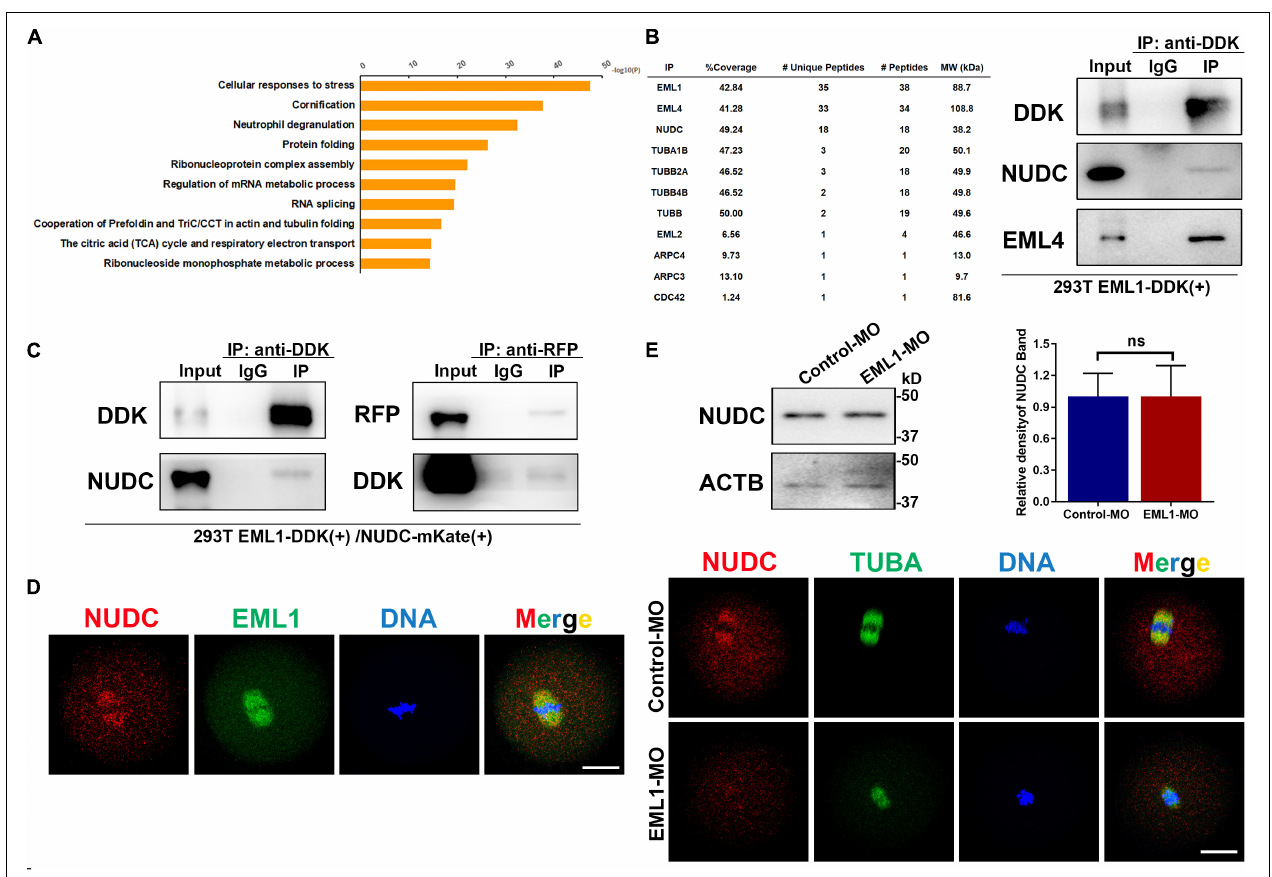
FIGURE 10 | Potential interacting partners identified for EML1. (A) Gene enrichment analysis of the interacting proteins of EML1 identified by IP-MS. (B) List of IP-MS identified EML1interacting proteins that are involved in spindle morphogenesis and actin polymerization (left table), and the validation of the presence of NUDC and EML4 in the EML1-IP product by WB analysis (right panel). (C) WB validation of the interaction between EML1 and NUDC. Expression of 3DDK-tagged EML1 and mKate-tagged NUDC proteins was achieved by simultaneously transfecting HEK293T cells with the corresponding plasmids. Co-IP and WB analysis were then carried out with the anti-DDK and anti-mKate antibodies. (D) IF staining images showing the co-localization of NUDC with EML1 on the spindles of MI-stage oocytes. (E) Knockdown of EML1 did not affect the expression levels of NUDC in the oocyte as indicated by the WB analysis in the top panel, but dislodged the localization of NUDC from the spindles in oocytes (bottom IF images). ns, denote no significant difference between the two groups compared. Scale Bar = 20 µ